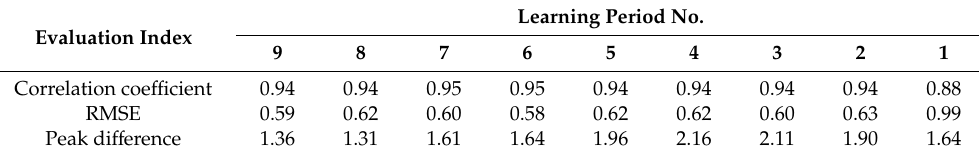
Table 20. Evaluation indices when learning period is changed (evaluation month: December).